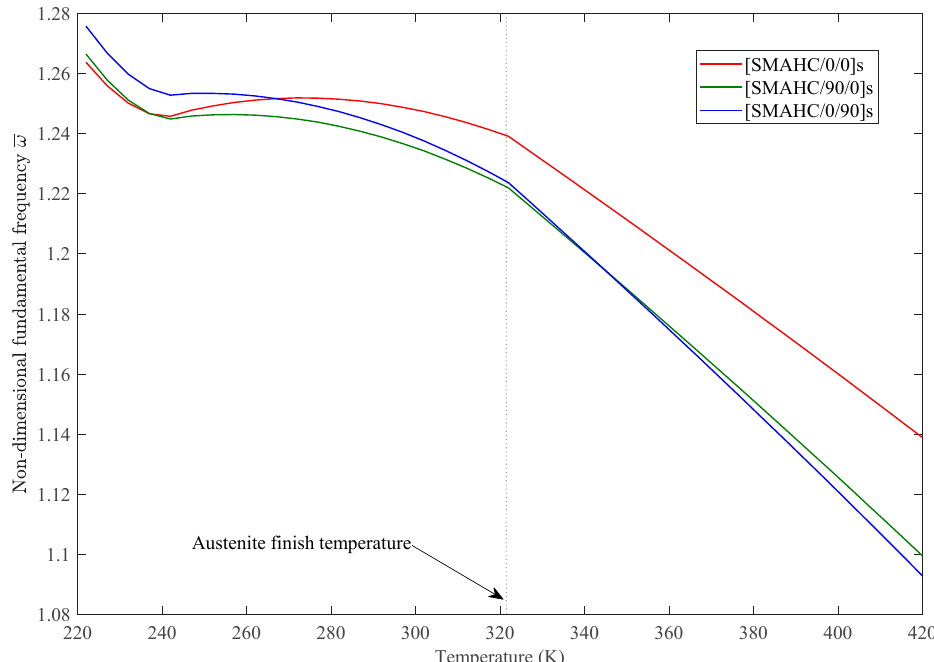
Figure 9. Variation of nondimensional fundamental frequency with temperature for different stacking sequences, with Vs = 30%, ε = 5%, CCCC boundary condition.